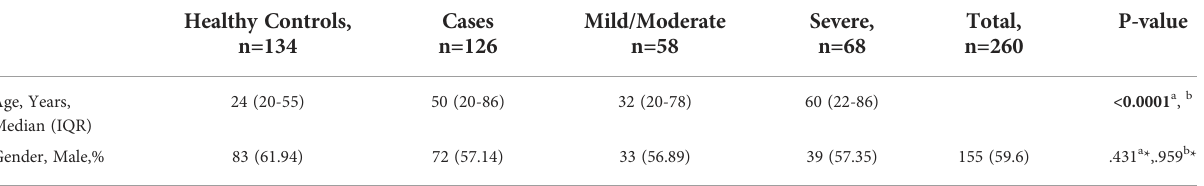
TABLE 1 Demographics characteristic of COVID-19 patients and healthy